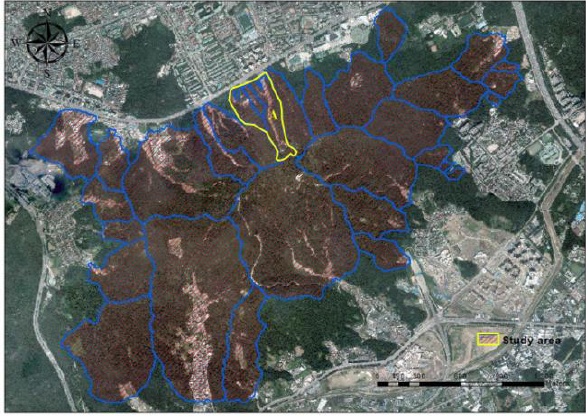
Figure 3. Aerial image of the study area, Mt. Umyeon, Seoul, South Korea, with watershed boundaries